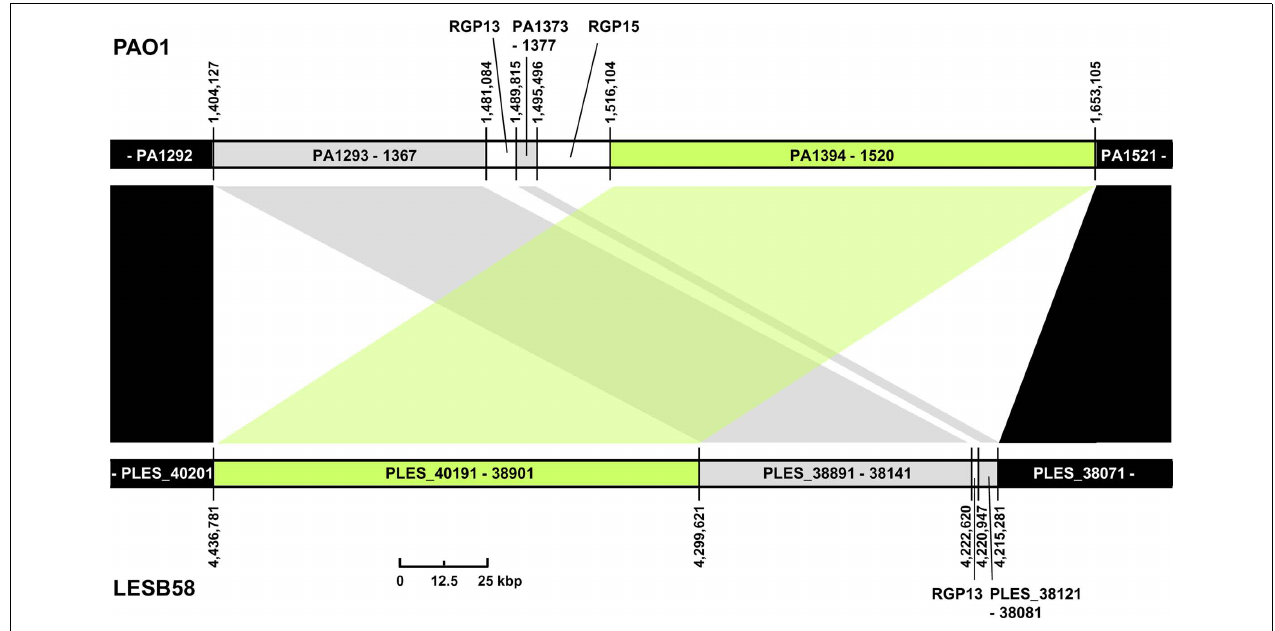
genome DNA arranged collinearly in both strains is shown in black, strain-specific insertions are represented by white areas. Genome coordinates of the borders of the core genome DNA blocks and numbers of the ORFs within are given for both strains. Accessory DNA blocks are described by the RGP number (see Table 2